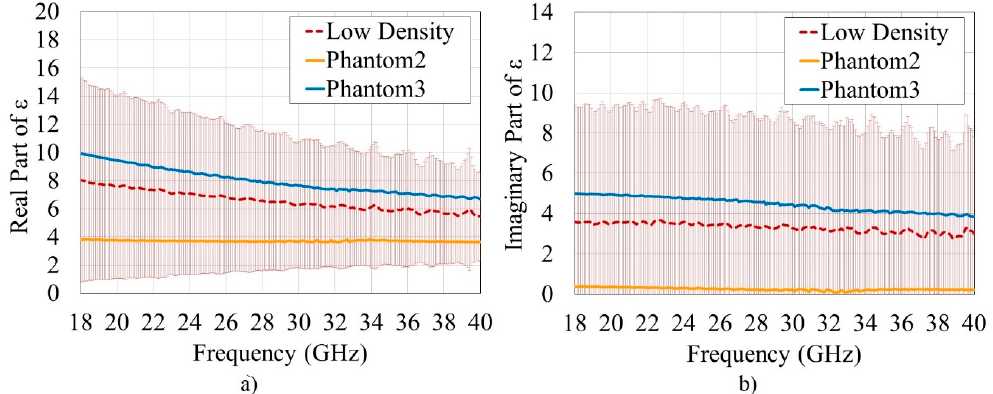
Figure 7. Comparison between the dielectric properties of the produced phantoms and the ones of the Low density ex vivo tissues [8] in the frequency range [18–40] GHz for the ( a ) real and ( b ) imaginary part of the dielectric permittivity. Table 2. Dielectric Properties of the Produced Phantoms @ 30 GHz.